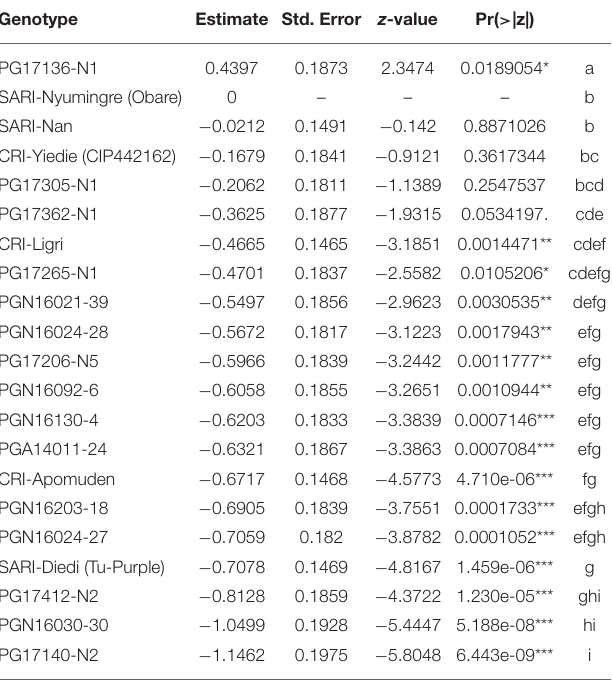
TABLE 4 | Plackett-Luce Model estimates from genotypes tested in Ghana. Genotype